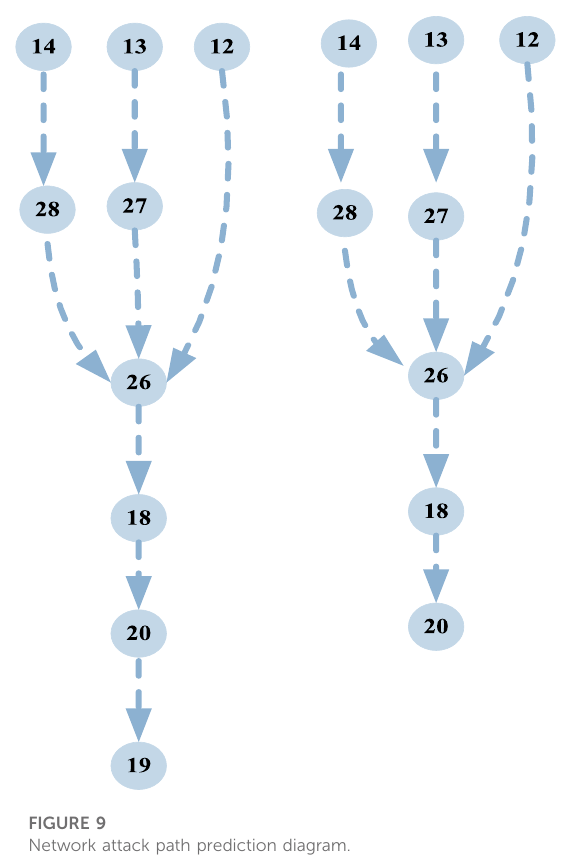
FIGURE 9 Network attack path prediction